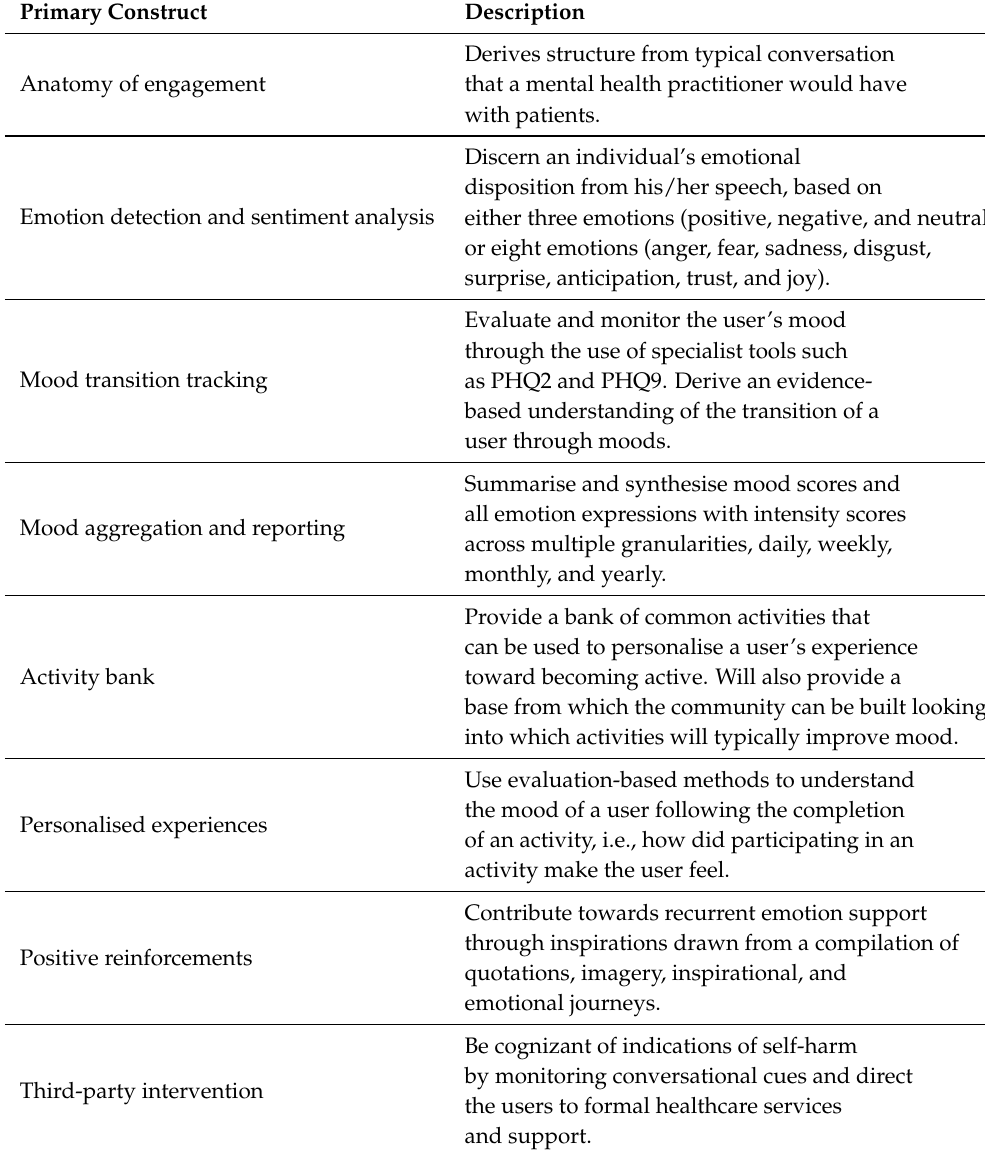
Table 1. The primary constructs of the BA-based AI chatbot. Primary